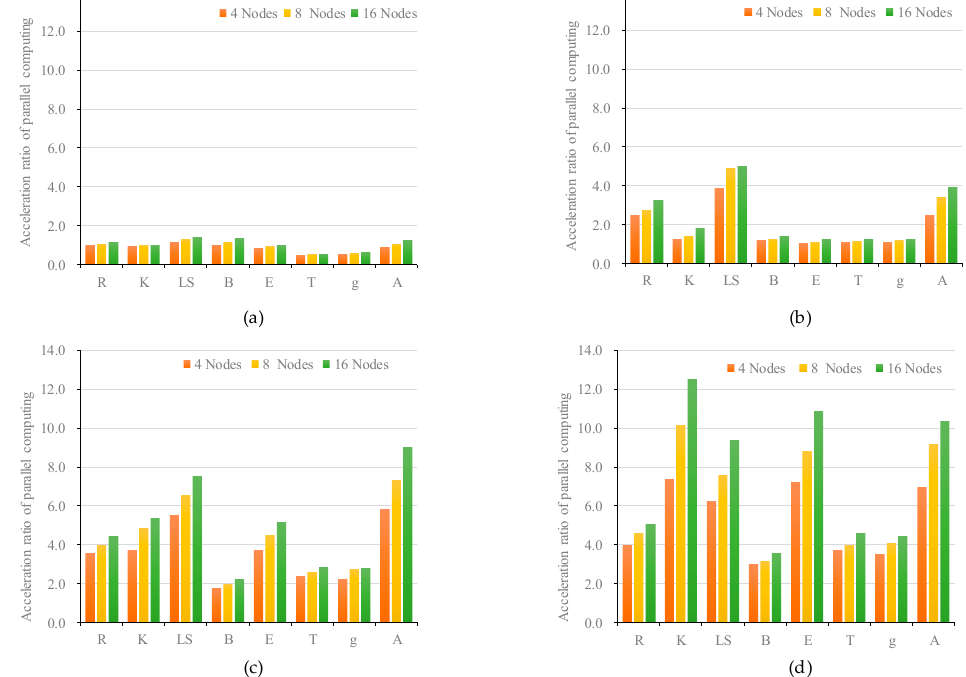
Figure 12. Parallel acceleration ratio for data with different spatial resolution. ( a ) raster cell width with 30 m; ( b ) raster cell width with 10 m; ( c ) raster cell width with 5 m; ( d ) raster cell width with 2.5 m.